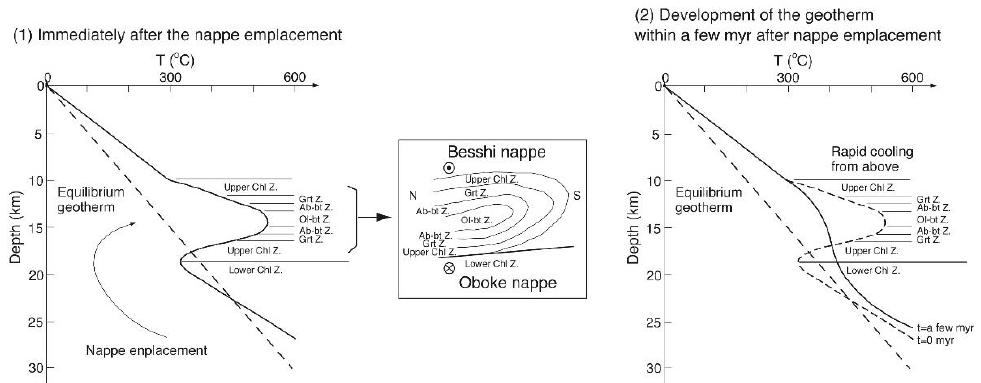
Figure 10. Schematic diagram to show the proposed development of geotherm during emplacement of the Besshi nappe (stage II in Figure 9). ( 1 ) Geotherm immediately after the nappe emplacement, and ( 2 ) development within a few myr after it are shown. The geotherm immediately after the nappe emplacement (t = 0 myr) and at a few myr after it (t = a few myr) is shown by dashed and solid lines, respectively. The equilibrium geotherm (20 °C/km) is drawn based on the peak-metamorphic conditions of the different metamorphic zones [34]. A pair of symbols consisting of a dot and cross in a circle in the inset diagram of ( 1 ) indicates the sense of the E-W flow (top to the west sense). See text for further explanations.